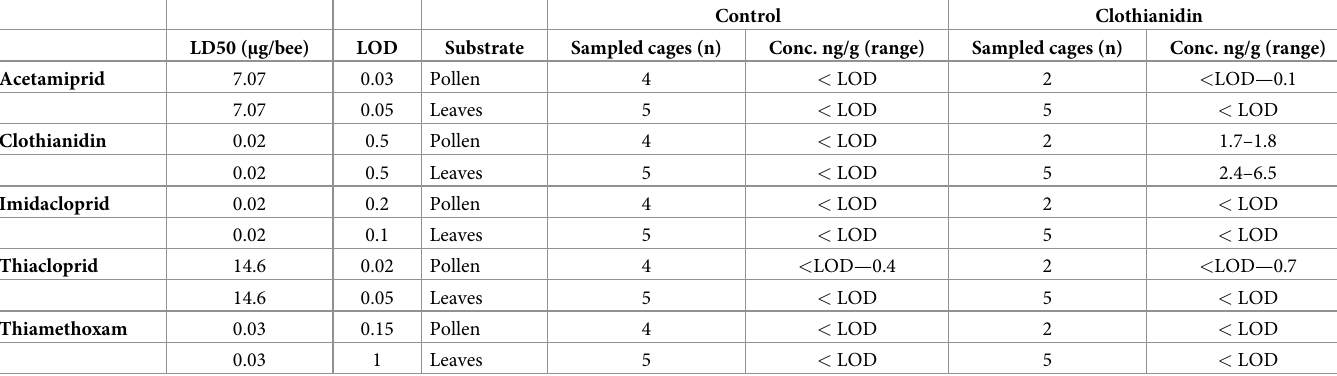
Table 1. Neonicotinoid residues in collected samples.